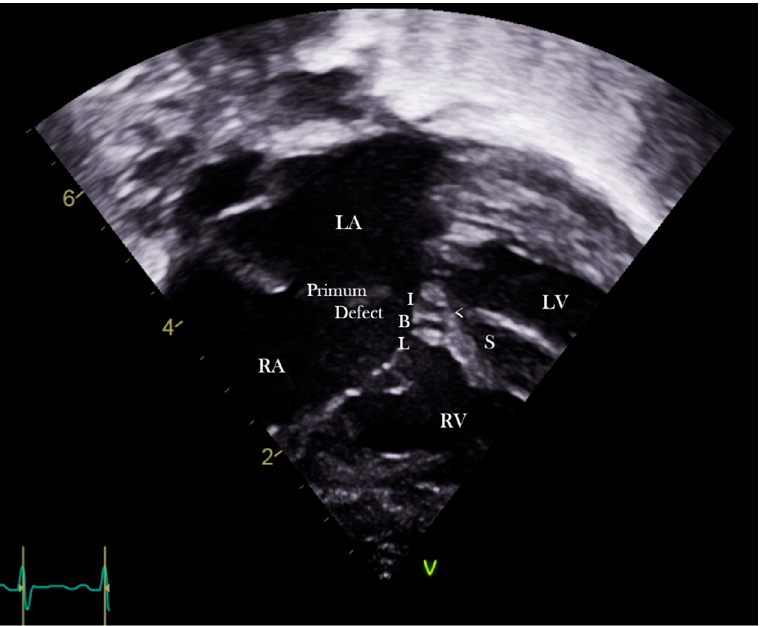
Figure 8. Subcostal echocardiographic four chamber section showing the inferior bridging leaflet.